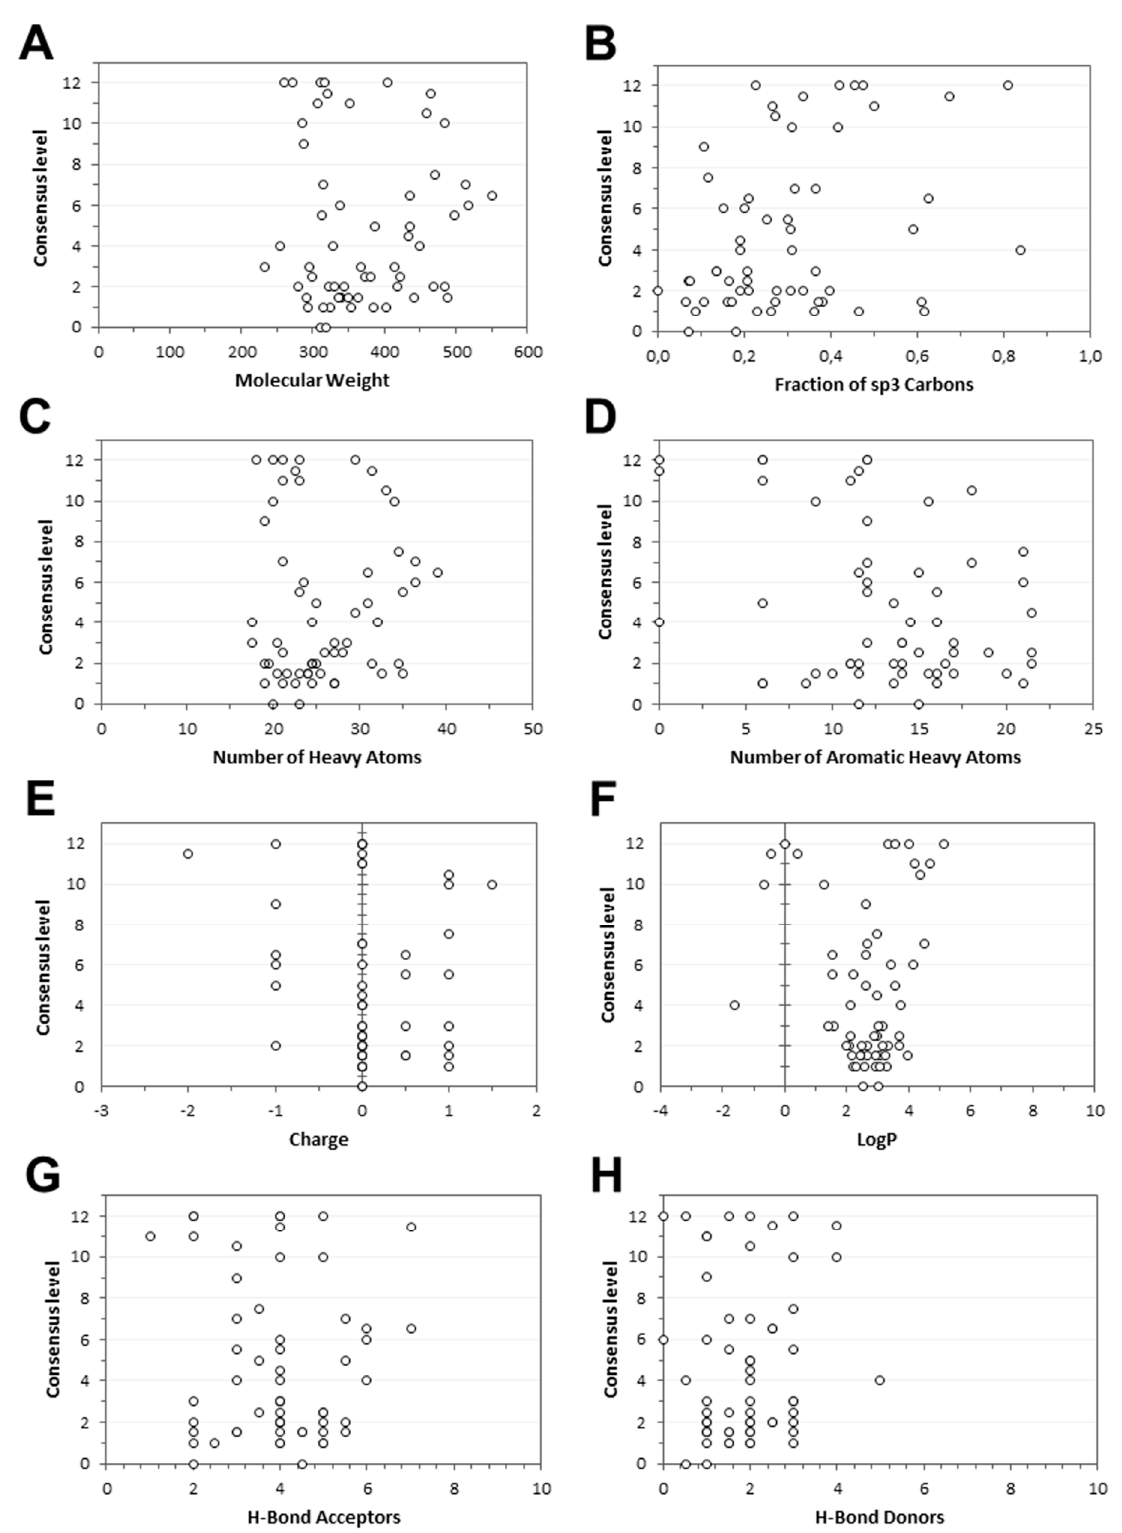
Figure 3. Analysis of the consensus docking results in relation to the ligand properties. ( A ) The molecular weight, ( B ) fraction of sp3 carbons, ( C ) number of heavy atoms, ( D ) number of aromatic heavy atoms, ( E ) charge, ( F ) log P , ( G ) number of H-bond acceptors, and ( H ) number of H-bond donors are reported in the graphs, respectively.